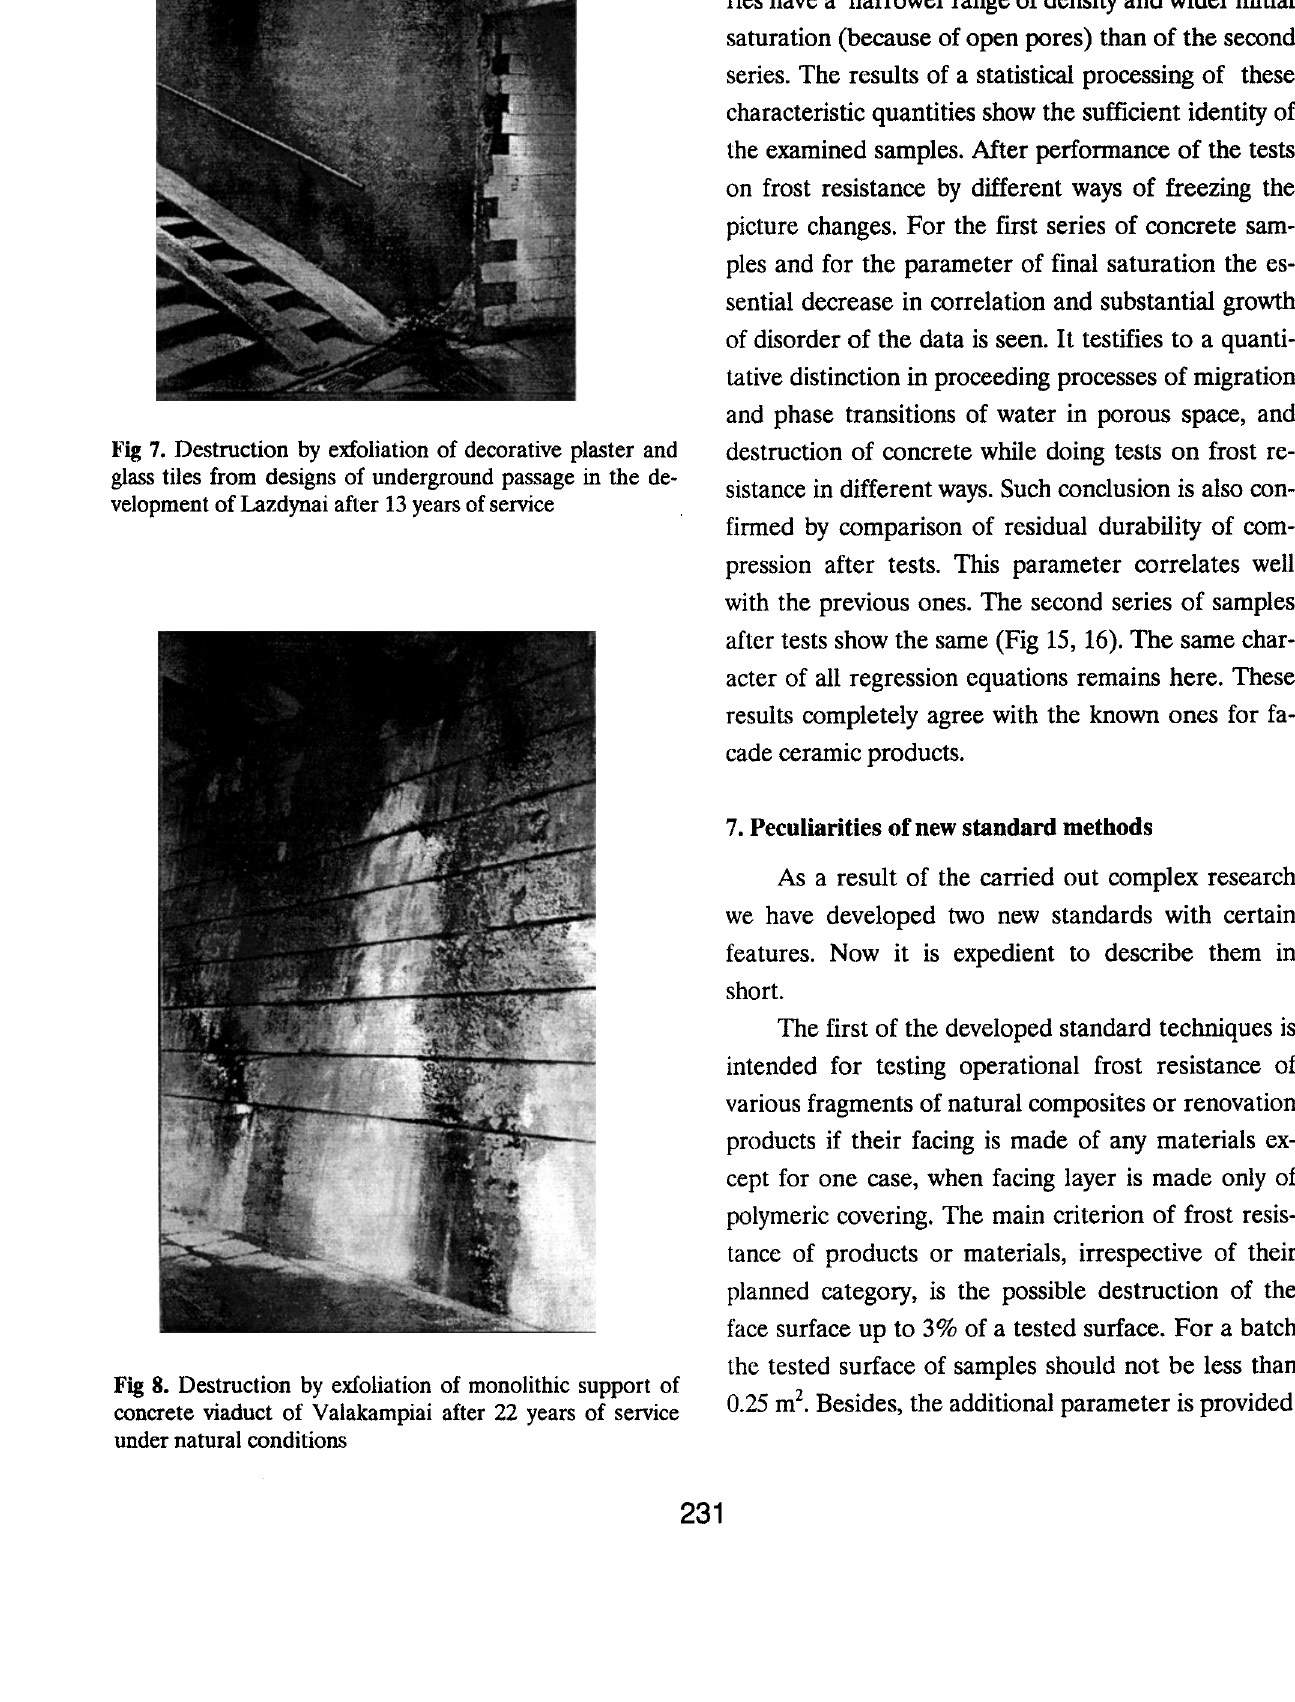
Fig 7. Destruction by exfoliation of decorative plaster